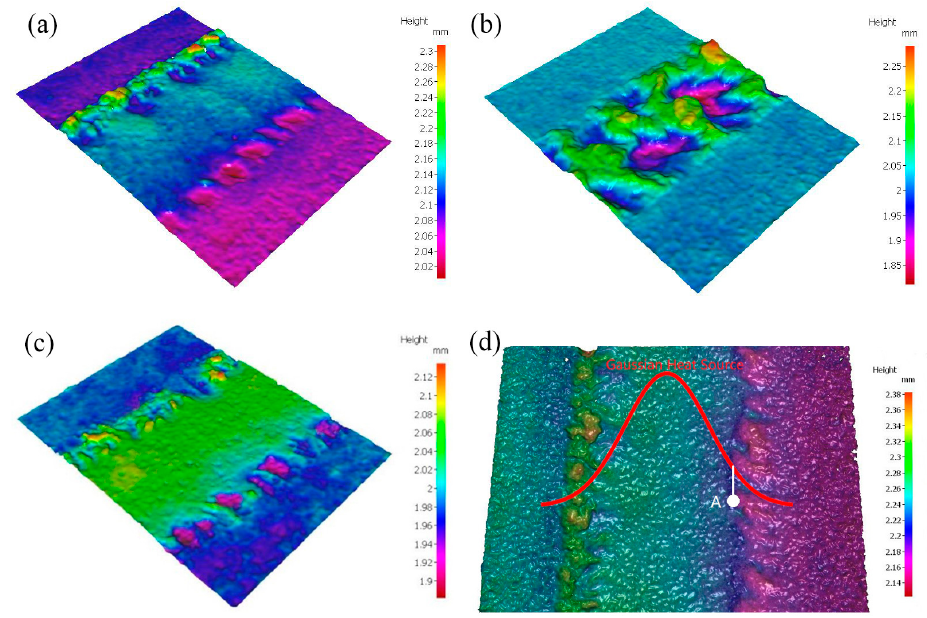
Figure 7. Three-dimensional surface topography: ( a ) point E in Figure 2b; ( b ) point F in Figure 2b; ( c ) point A in Figure 2c; ( d ) point B in Figure 2c and the Gaussian heat source distribution.